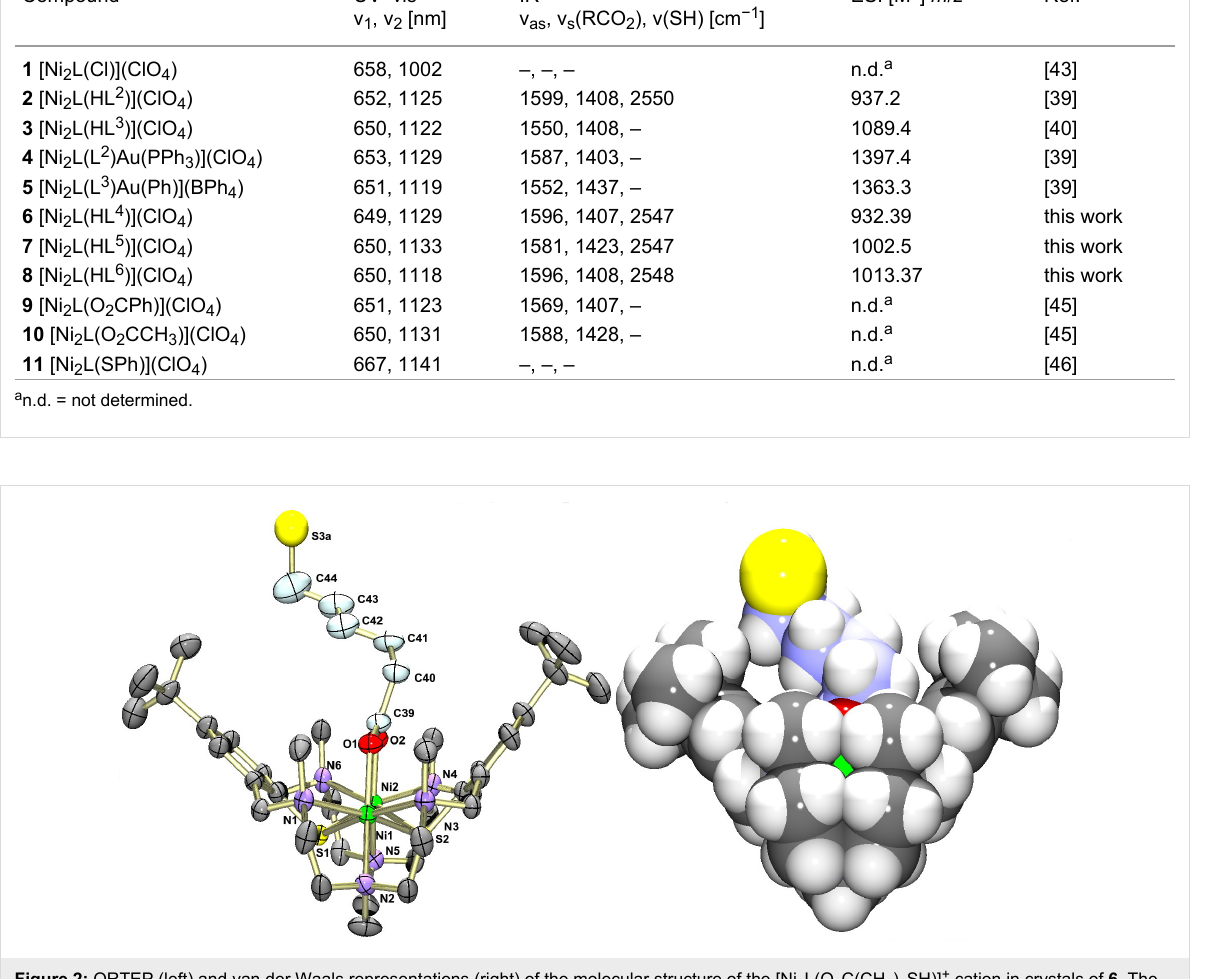
Table 1: Selected UV–vis spectroscopy, IR spectroscopy, and ESIMS data and their assignments for compounds 6 – 8 . The data for the reference compounds ( 1 – 5 , 9 – 11 ) have been included for comparison. Compound